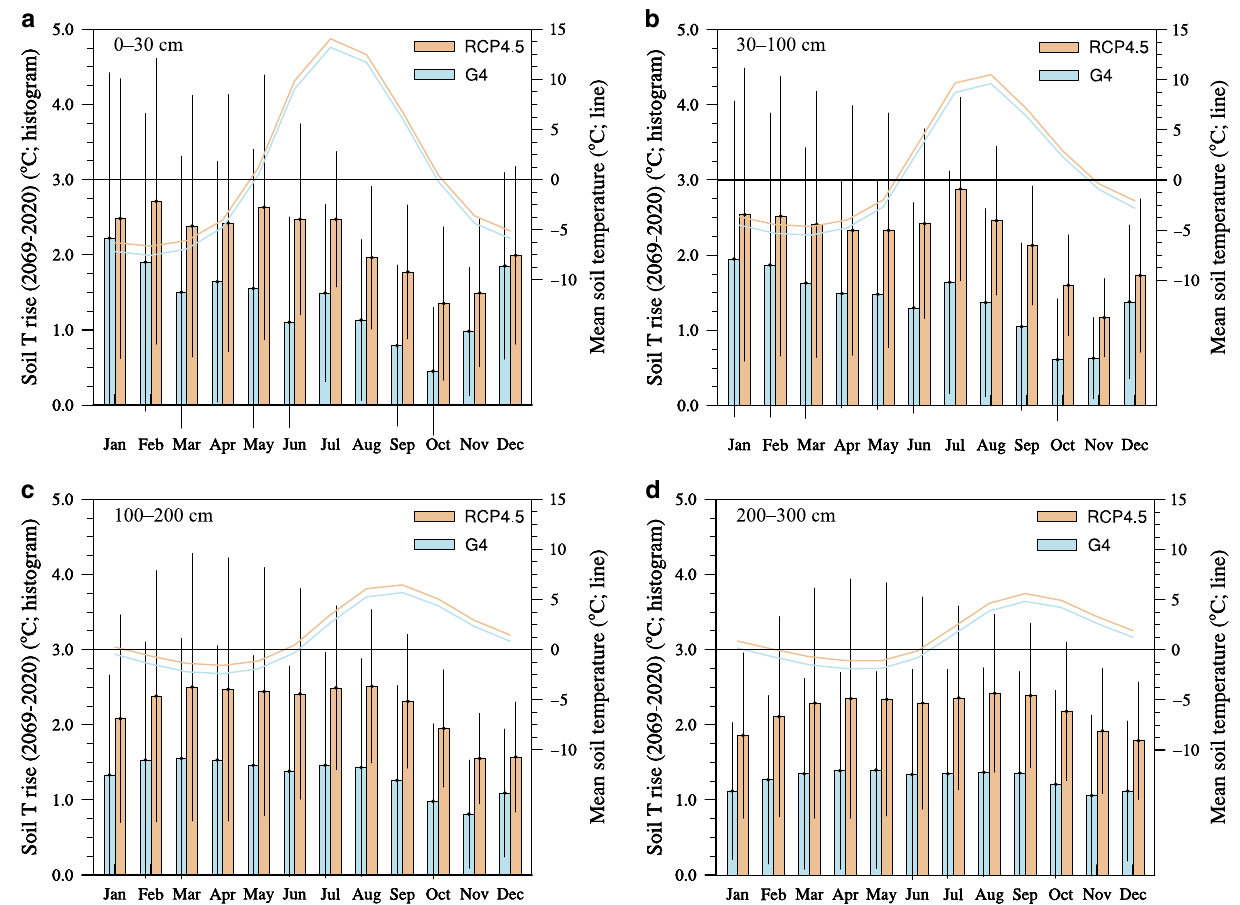
Fig. 3 Monthly soil temperature and its changes between 2020 and 2069. Histograms with error bars (left axes) show the monthly soil temperature change over the period 2020-2069 under the emission scenario RCP4.5 and the geoengineering experiment G4, and line plots (right axes) show the mean soil temperatures at different soil depths ( a ) 0 – 30 cm, ( b ) 30 – 100 cm, ( c ) 100 – 200 cm and ( d ) 200 – 300 cm over the same period. Soil temperatures are ensemble means from the bias-corrected ESM outputs. The cooling effect of SAI is signi fi cant from May to October, mitigating summer warming and retaining carbon from permafrost.